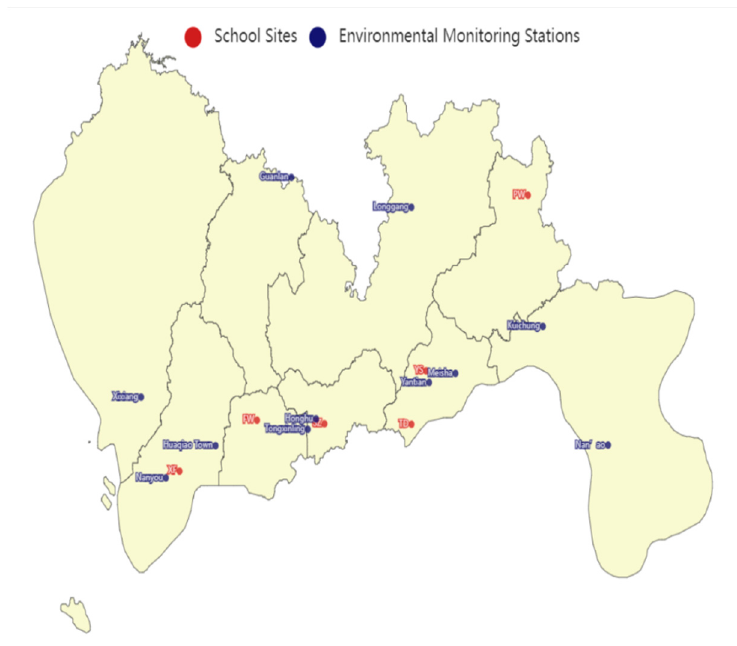
Figure 1. The distribution of environmental monitoring stations and schools.